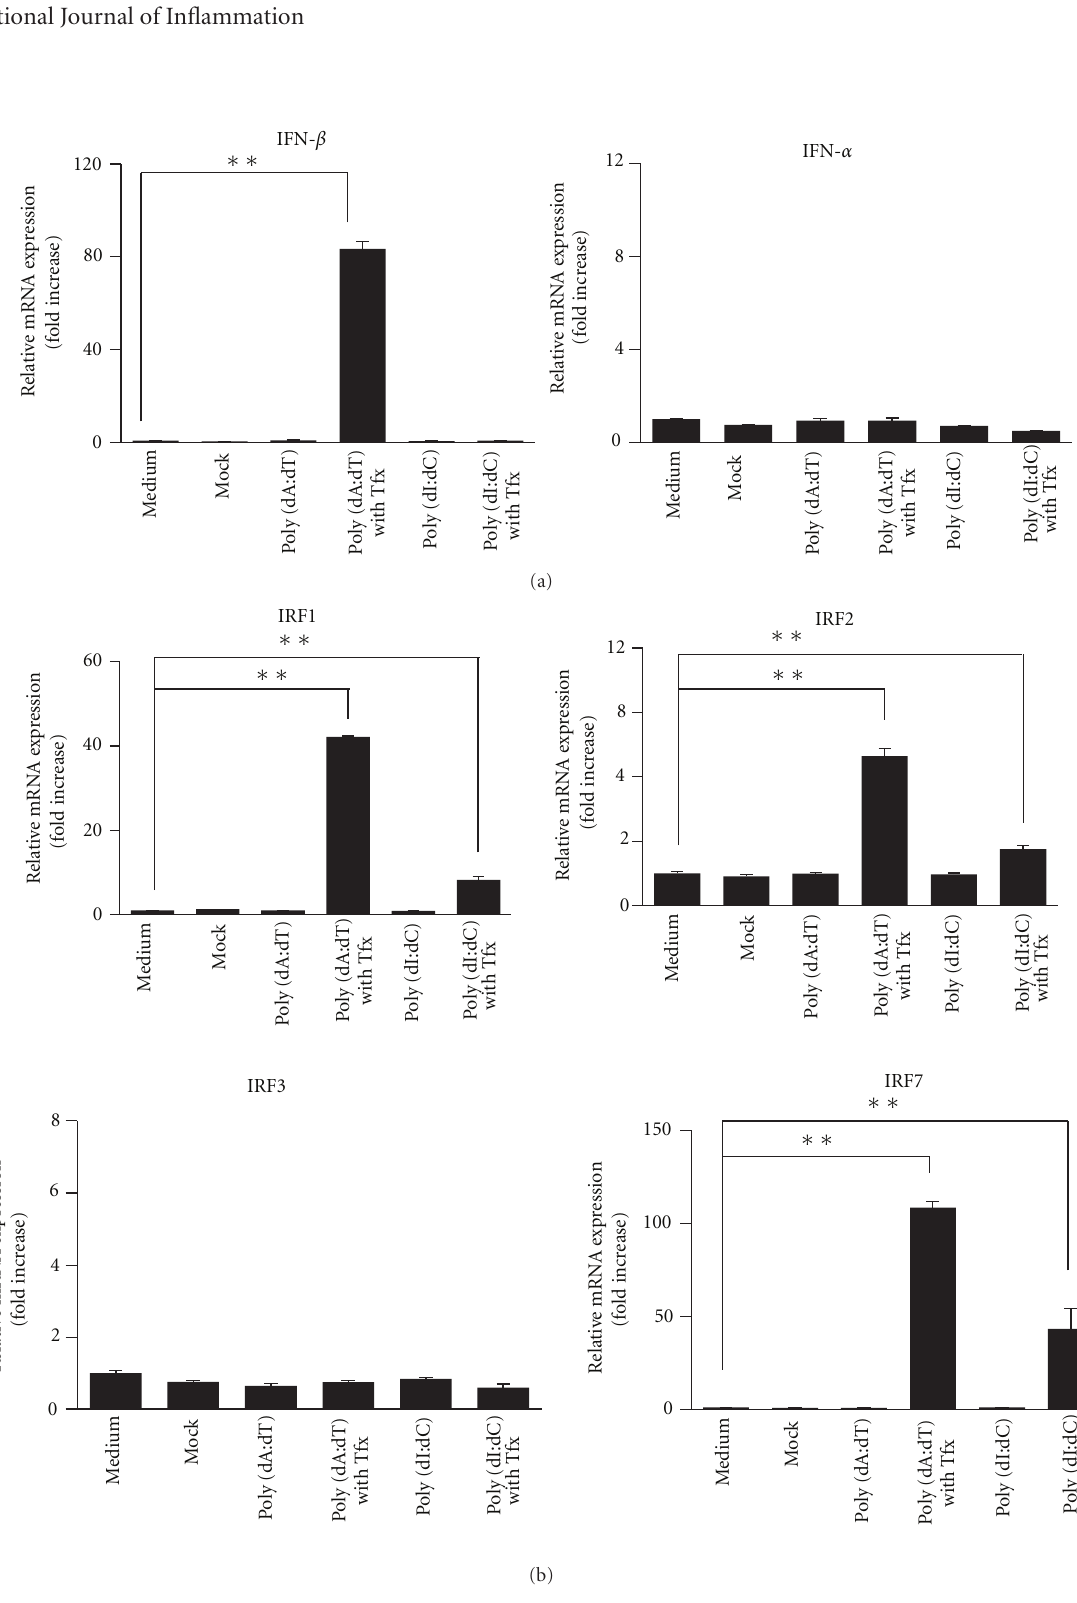
Figure 4: Transcription of type I interferon mRNA is induced by synthetic double-stranded DNA (dsDNA). (a) Extracellular DNA stimulation had no e ff ect on the induction of type I interferons (IFNs), such as IFN- α and IFN- β . In contrast, intracellular dsDNA (at 10 μ g/mL) has stimulatory e ff ects on their expression, including the expression of their transcriptional factors interferon regulatory factor 1 (IRF1), IRF2, and IRF7 (b). TFx: + transfection reagent lipofectamine. ∗ P < 0 . 05, ∗∗ P < 0 .